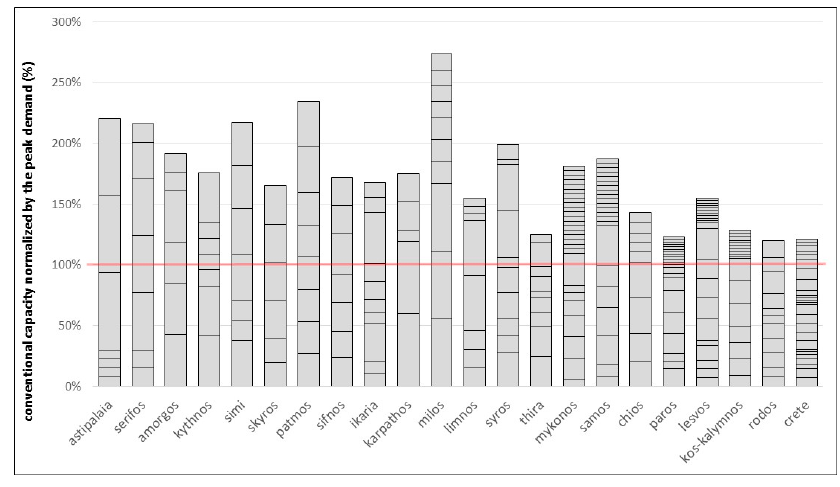
Figure 2. Splintering of conventional capacity normalized by the peak demand.